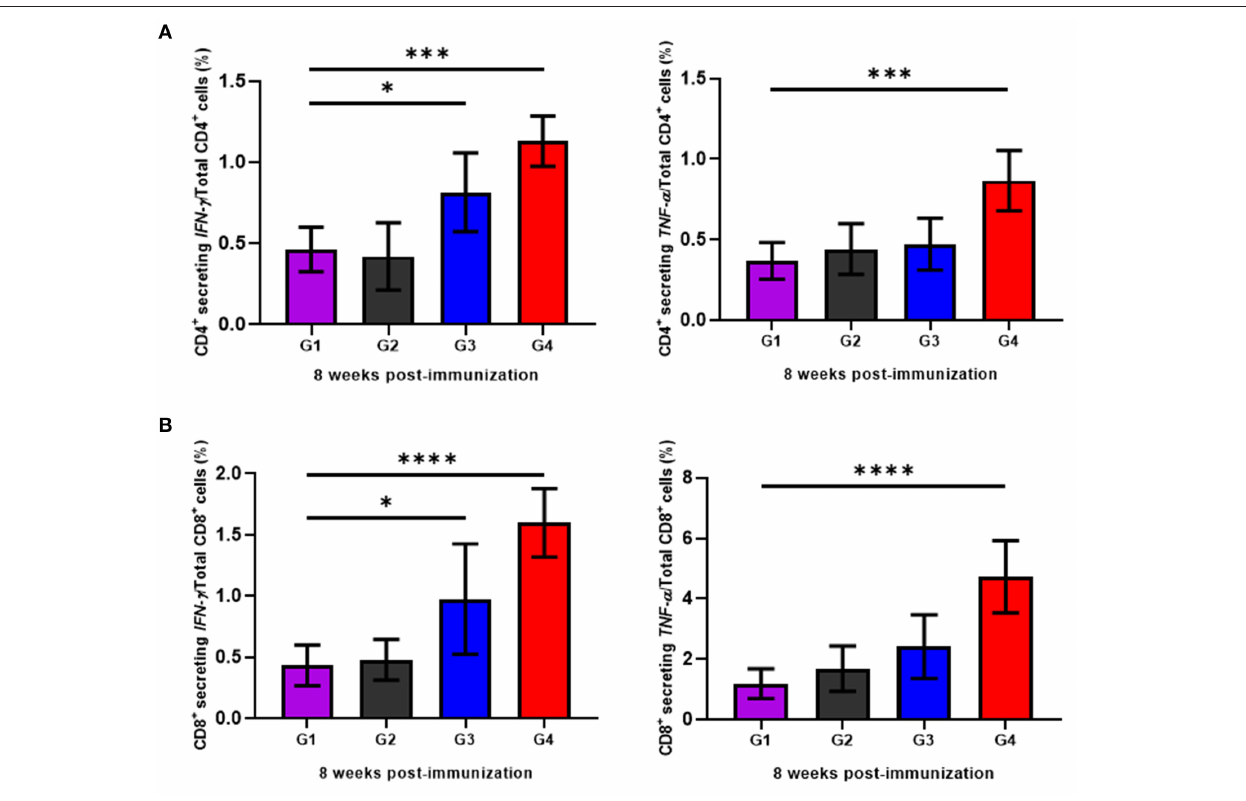
FIGURE 4 | Determination of cellular immune response of cattle immunized with rBbAMA-1(I/II) analyzed by flow cytometry analysis. (A) Frequency of IFN- γ and TNF- α secreting CD4 + T cells. (B) Frequency of IFN- γ and TNF- α secreting CD8 + T cells. The results are expressed as group mean values ± SD. Asterisks indicate a significant difference (* < 0.05; *** < 0.001; **** < 0.0001). Experimental groups G1 = non-immunization, G2 = Montanide ISA 206 VG + PBS, G3 = rBbAMA-1(I/II) 50 µ g + Montanide ISA 206 VG and G4 = rBbAMA-1(I/II) 100 µ g + Montanide ISA 206